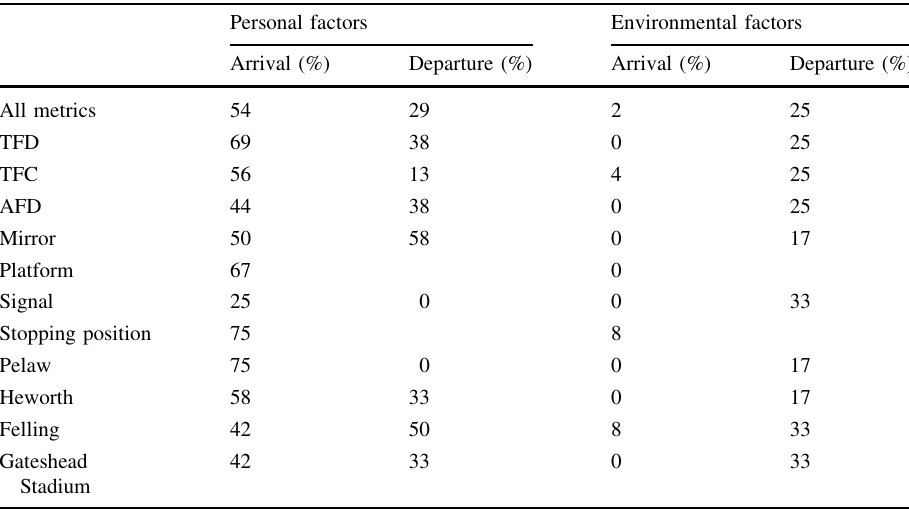
Table 5 Summary of importance of personal and environmental factors by metric, location and AOI ( p \ 0.05